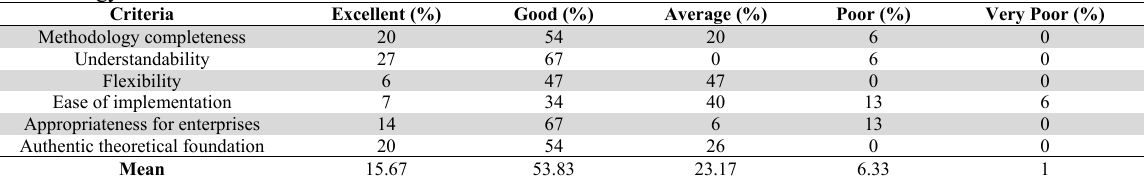
Methodology assessment